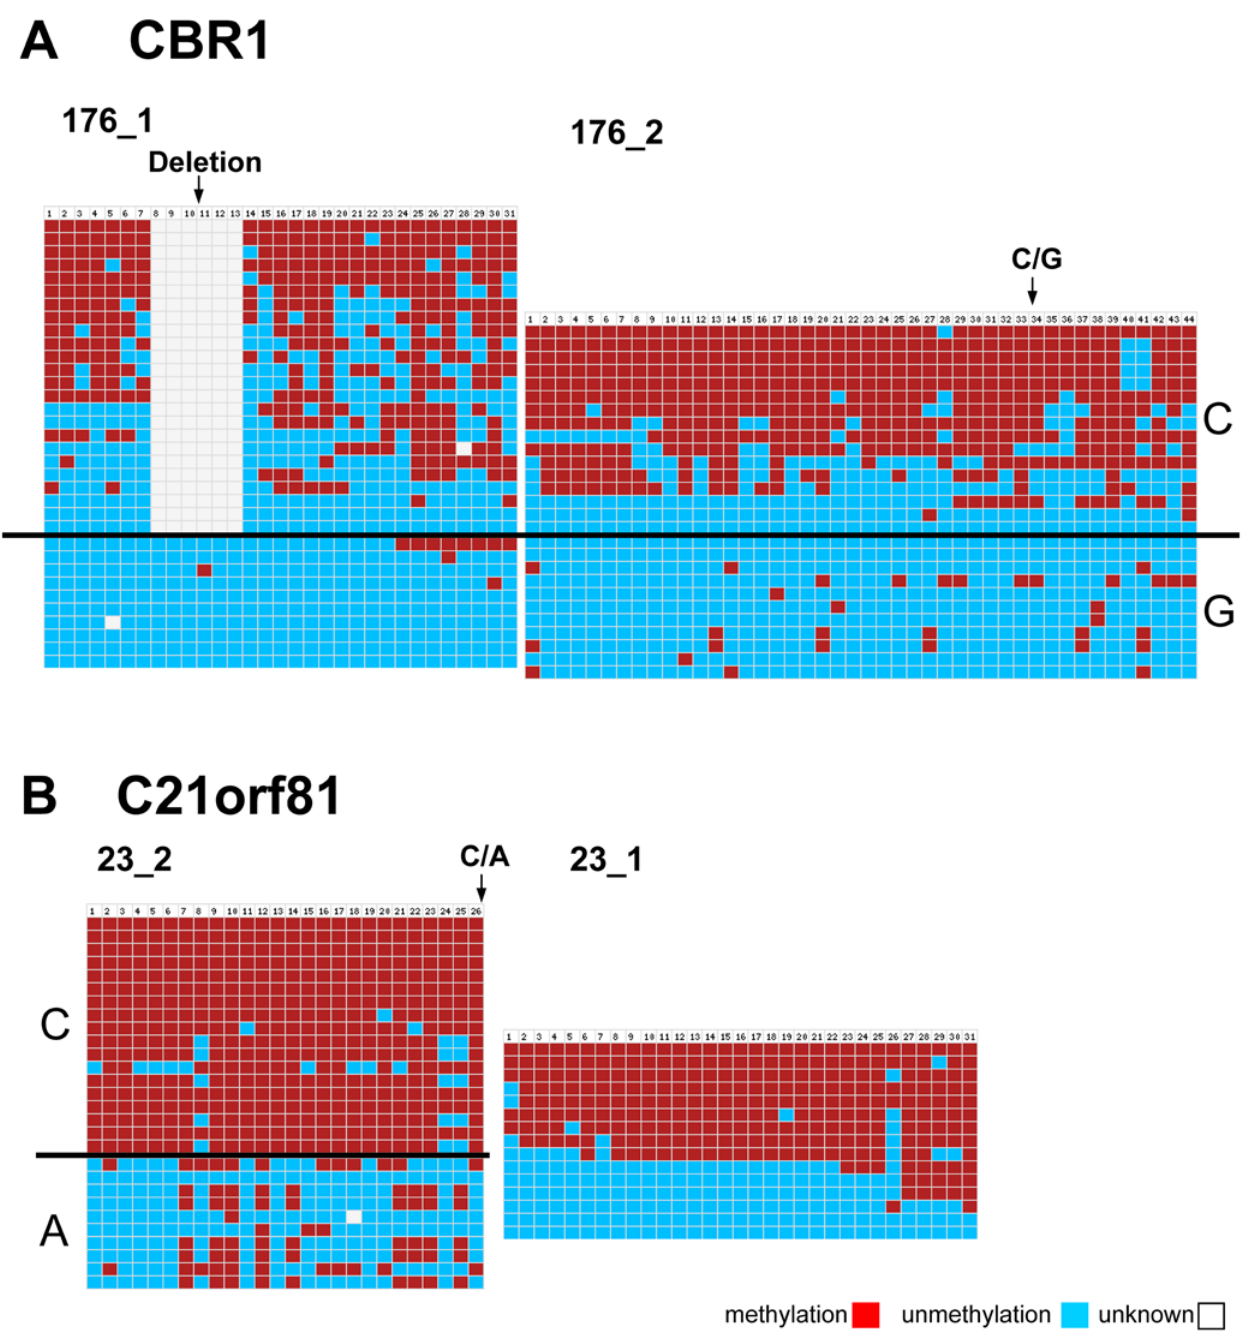
Figure 9. Allele-specific DNA methylation. (A) Allele-specific methylation of two amplicons (176_1 and 176_2) in the promoter of the CBR1 gene. For 176_1 clones were sorted according to the presence of a deletion (dbsnp rs41563015) in the bisulfite sequencing results. For 176_2, the clones were sorted according to the presence of C/G SNP (dbsnp rs25678). (B) Allele-specific methylation of amplicon 23_2 from gene C21orf81. A/C SNP (dbsnp rs56270809) was used to differentiate alleles. The positions of all SNP sites are indicated by arrows. Each row corresponds to one clone of bisulfite PCR products. Each column corresponds to one CpG site in the studied region. The color codes indicate the different methylation states of each CpG site in each clone. See Text S6 for details on the methylation patterns of these amplicons in other tissues analyzed.